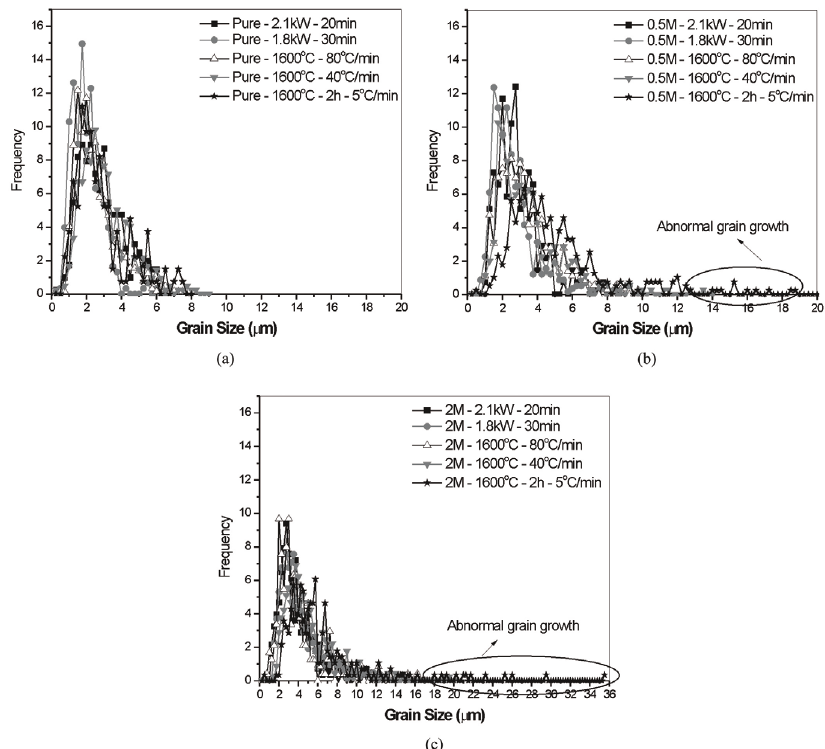
Figure 8. Grain size distribution of sintered MgO doped samples: (a) Pure, (b) 0.5M, (c) 2M.